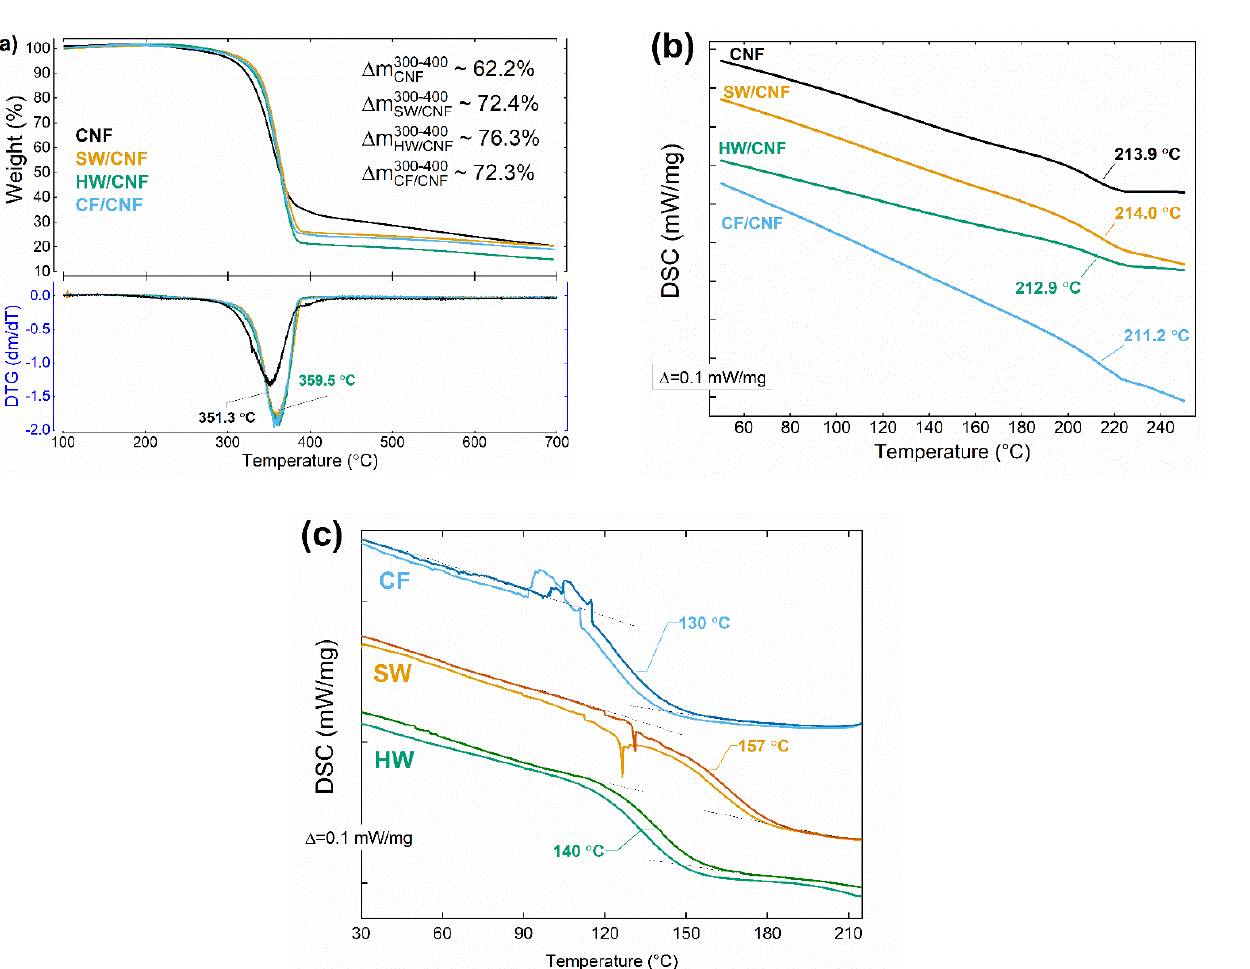
Figure 8. ( a ) Thermogravimetric analysis and ( b ) dynamic scanning calorimetry analysis of the nanocellulose–lignin membranes. ( c ) Dynamic scanning calorimetry analysis of the lignins.